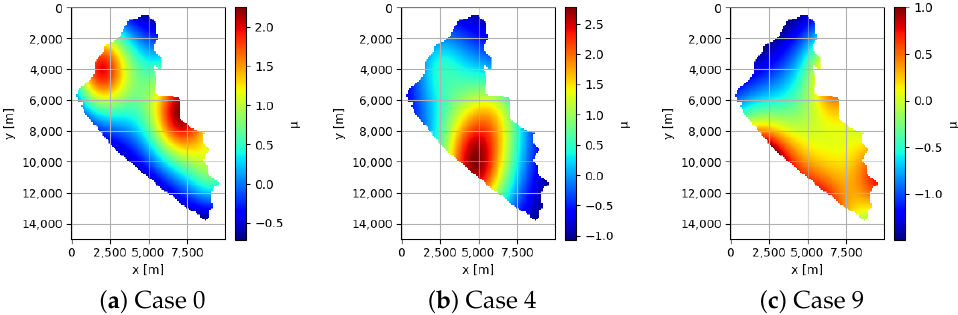
Figure 5. Example of 3 ground truths of the 10 simulated ground truths obtained with the Shekel function using the Ypacarai Lake as simulated scenario